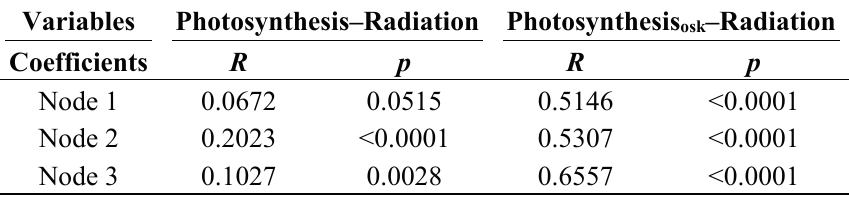
Table 2. Correlation analysis results for radiation against photosynthesis with and without filtering.